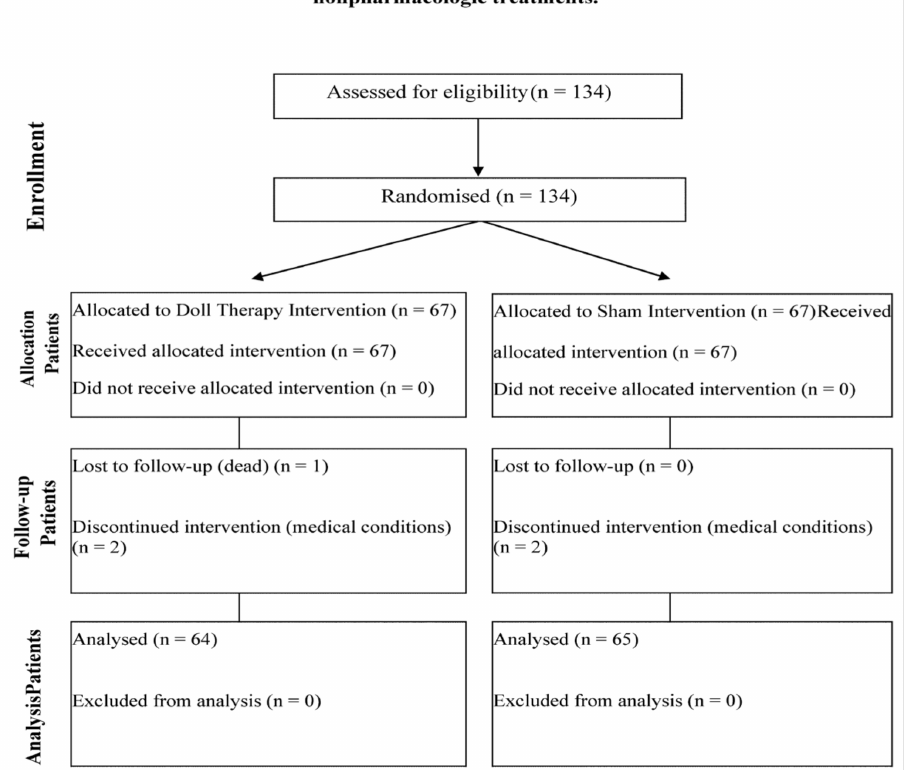
Figure 1. CONSORT flow diagram for individual randomized controlled trials of nonpharmacologic